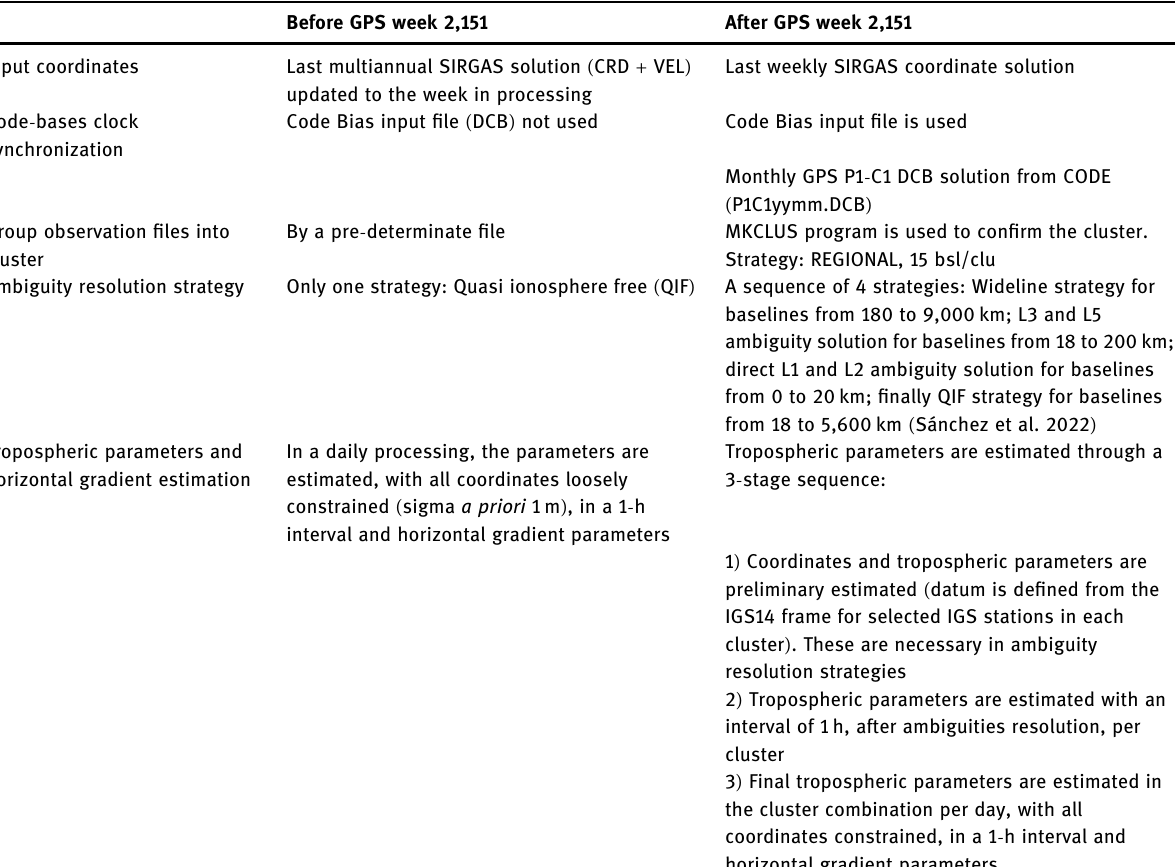
Table 3: Main changes implemented in the USC processing strategy from GPS week